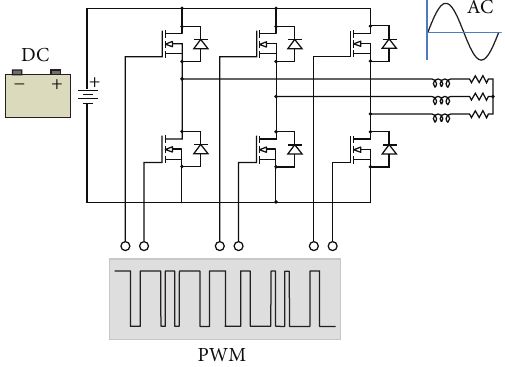
Figure 1: Schematic structure of a voltage PWM inverter. (𝑠) times 𝑡